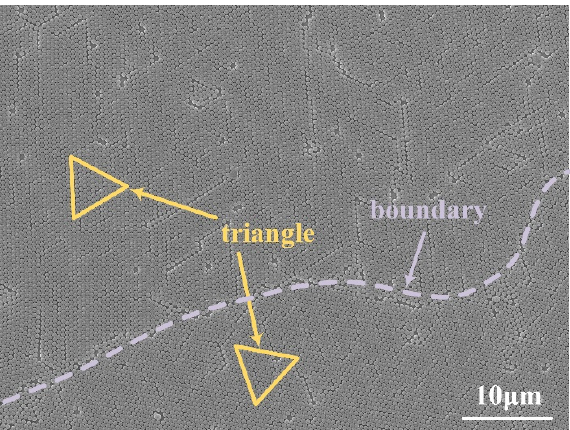
Figure 5. The reflection properties as a function with the operation wavelength in the simulations and experiments for the self-assembled nanopillars structures ( a ), and nanoholes structures ( b ). The inset is the calculation model of nanopillars and nanoholes structures in the 3D FDTD simulation.